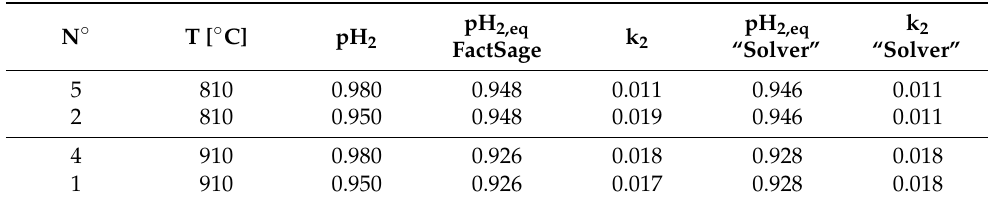
Table 3. Equilibrium partial pressure and k 2 rate constants for experiments 1, 2, 4 and 5 according to the two methods employed, using FactSage or a solver.